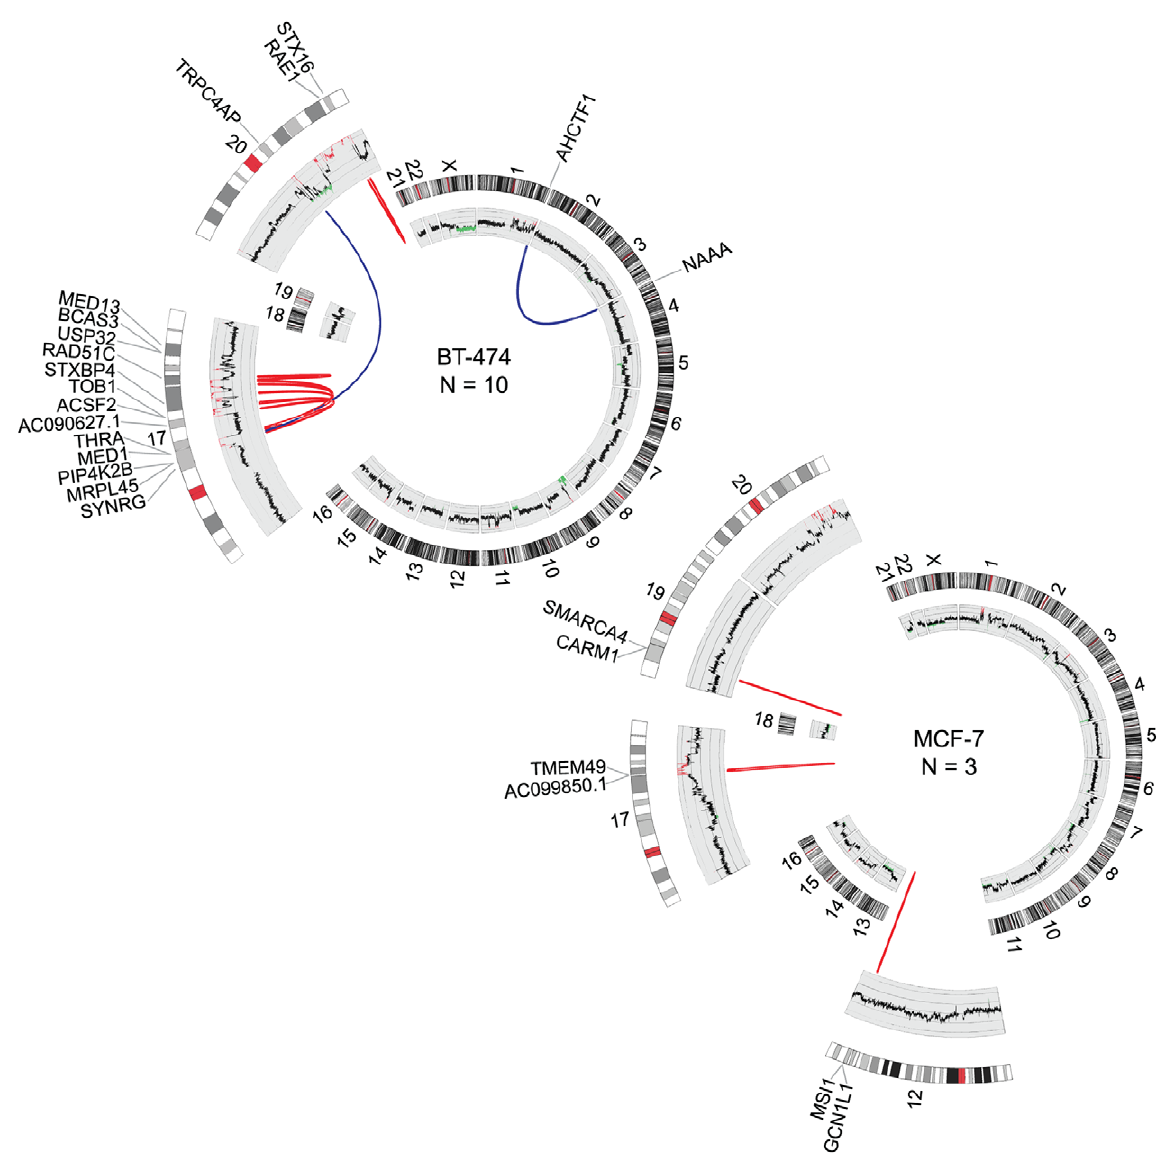
Figure 2. Genomic rearrangements underlying fusion gene formation. Circos plots illustrating chromosomal translocations in BT-474 (upper) and MCF-7 (lower). Chromosomes are drawn into scale around the rim of the circle and data are plotted on these coordinates. Intrachromosomal (red) and interchromosomal (blue) fusions are indicated by arcs. Copy number profiles are plotted in the inner circle. Amplifications are shown in red and deletions in blue. N denotes the number of fusion genes per cell